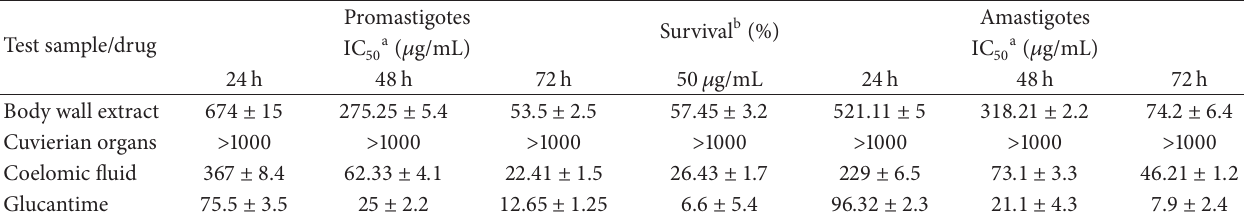
Table 1: In vitro antileishmanial activity of H. leucospilota and reference drug Glucantime against L. infantum promastigotes and amastigotes in different time points.